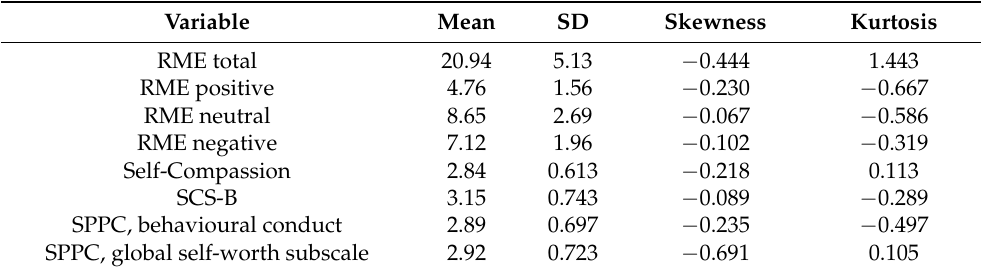
Table 1. Descriptive